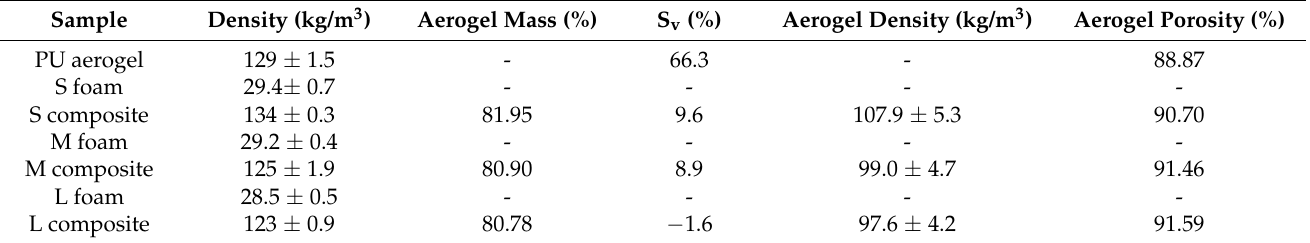
Table 2. Densities, aerogel mass, and volumetric shrinkage of the PU F –PU A